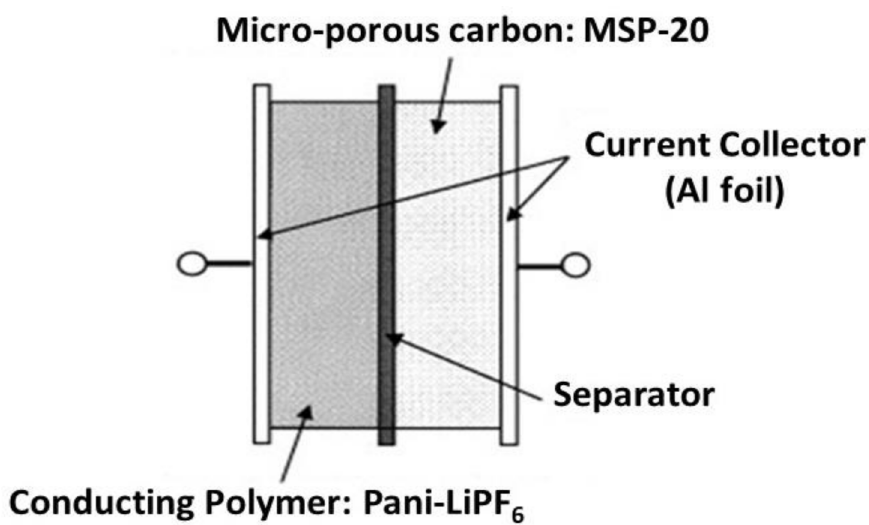
Figure 8. Hybrid type supercapacitor. Reproduced with permission from